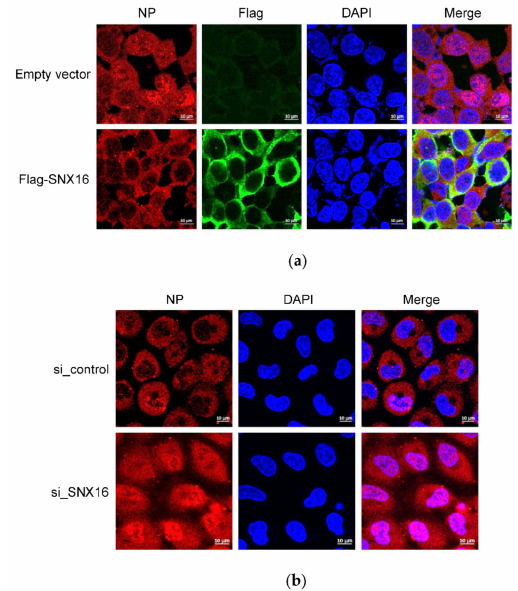
Figure 7. SNX16 is involved in the early stage of IAV replication cycle. ( a ) HEK293T cells were transfected for 48 h to express empty vector or Flag-SNX16, and then infected with WSN (H1N1) virus at an MOI of 5. At 2 h p.i., the infected cells were fixed and stained with a mouse anti-NP mAb and a rabbit anti-Flag pAb, followed by incubation with Alexa Fluor 633 goat anti-mouse IgG (H + L) (red) and Alexa Fluor 488 goat anti-rabbit IgG (H + L) (green). The nuclei were stained with DAPI. ( b ) A549 cells were transfected with siRNA targeting SNX16 or with scrambled siRNA for 48 h and were then infected with WSN (H1N1) virus at an MOI of 5. At 2 h p.i., the infected cells were fixed and stained with a mouse anti-NP mAb, followed by incubation with Alexa Fluor 633 goat anti-mouse IgG (H + L) (red). The nuclei were stained with DAPI. Data are representative of three independent